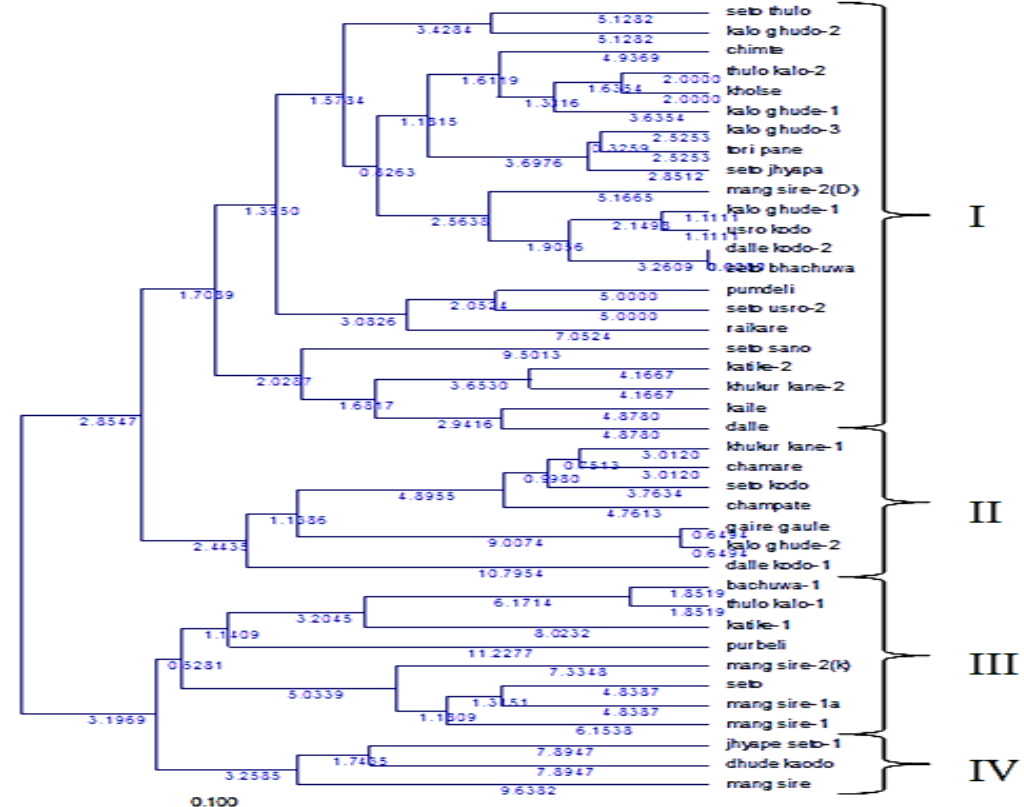
Figure 4 . Dendrogram of 40 finger millet landraces based on Nei’s genetic distance of 9 RAPD markers using UPGMA methods with bootstrap of 1000 replications